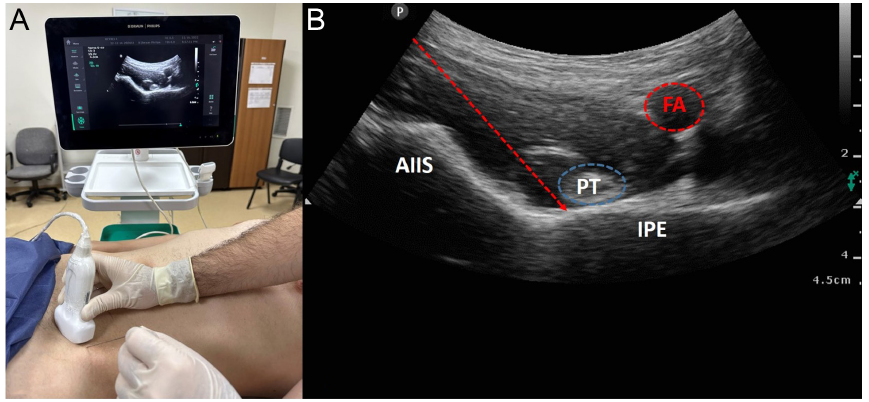
Figure 9. A, B. (A) Patient and ultrasound probe position for pericapsular nerve group block procedure. (B) Sonographic anatomy of the block. AIIS, anterior inferior iliac spine; FA, femoral artery; IPE, iliopubic eminence; PT, psoas muscle tendon; red arrow, needle.